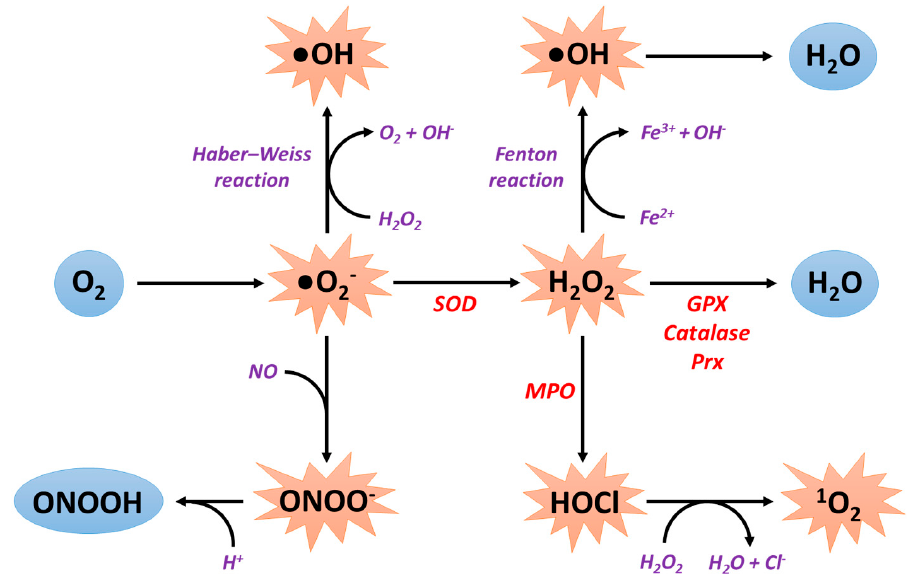
Figure 1. ROS formation and detoxification. 1 O 2 : singlet oxygen; Cl − : chloride ion; Fe 2+ : iron (II) ion;